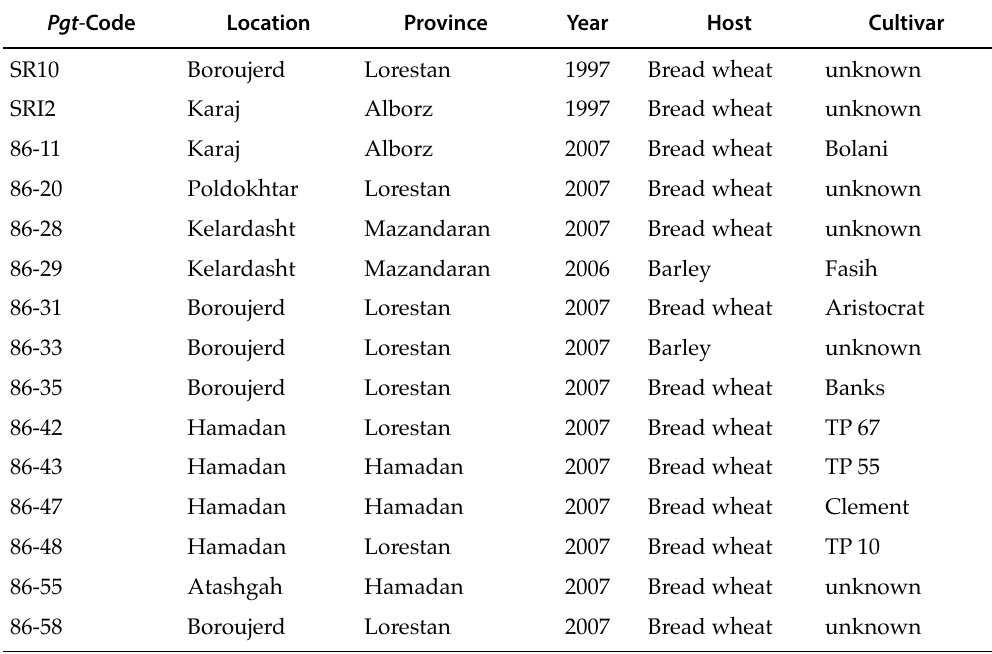
Table 1. Isolate code, site and year of collection, name of host cultivar for 15 Puccinia graminis f. sp. tritici collections.